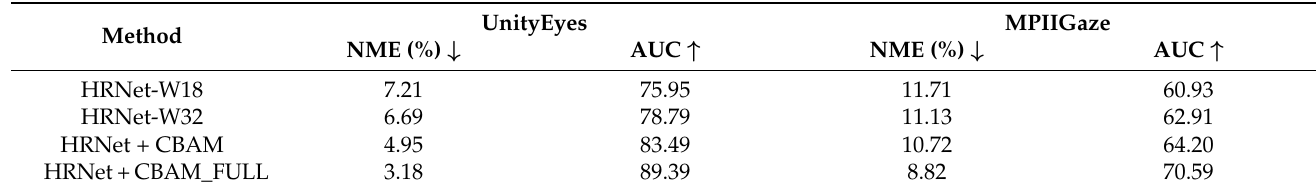
Table 4. The approaches that applied a CBAM module improved the quantitative metric.